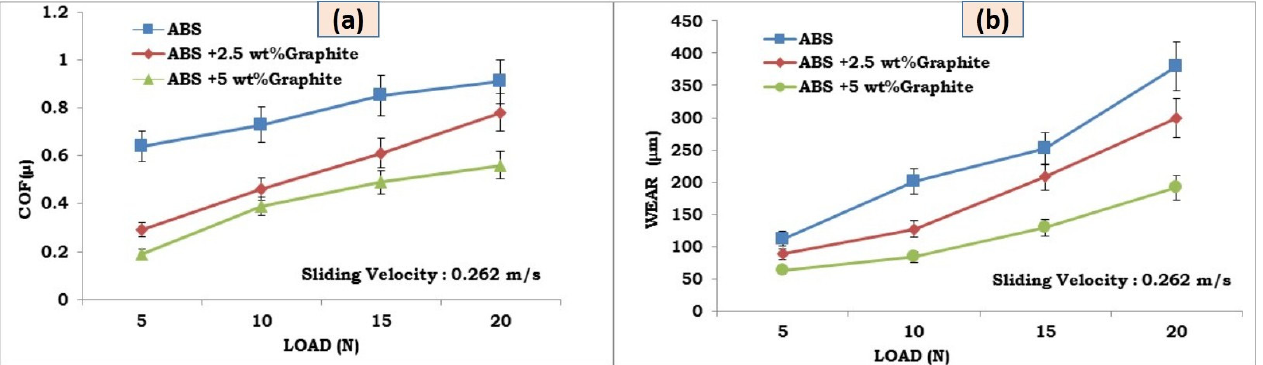
Figure 4. ( a , b ) Graphical representation of effect of load on coefficient of friction and wear loss for unfilled and graphite filled ABS parts developed by FDM process.